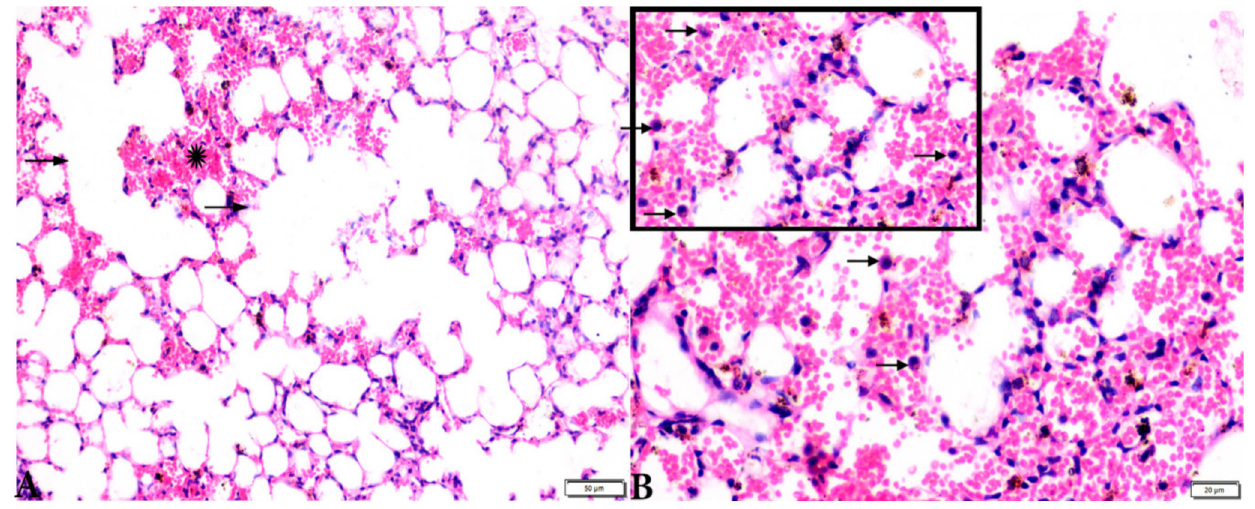
Figure 8. Photomicrograph of H&E-stained lung tissue sections from T. gondii -infected animals treated with propolis (G3) showing: ( A ): alveolar emphysema (arrows), interstitial hemorrhage (stars), and ( B ) infestation with multiple tissue cysts (arrows). The scale bar is provided below each image.